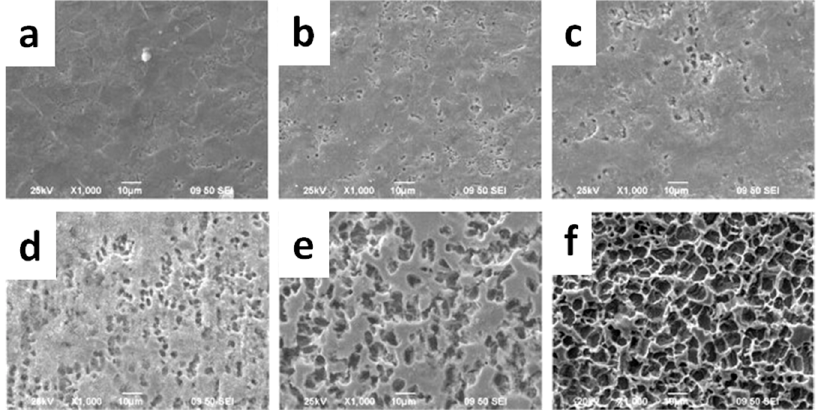
Figure 12. SEM images of zinc oxide films with different pore densities prepared by the anodic oxidation technique using different oxidation times. ( a ) 2 min; ( b ) 5 min; ( c ) 10 min; ( d ) 15 min; ( e ) 90 min; ( f ) 120 min. Modified with permission from reference [95]. Copyright (2011) Elsevier. NIH 3T3 fibroblasts were cultured for 48 h on porous ZnO films and their morphology and distribution evaluated by fluorescence microscopy. The obtained results showed that the proliferation and spreading of fiborblasts was significantly inhibited by the presence of the porous ZnO